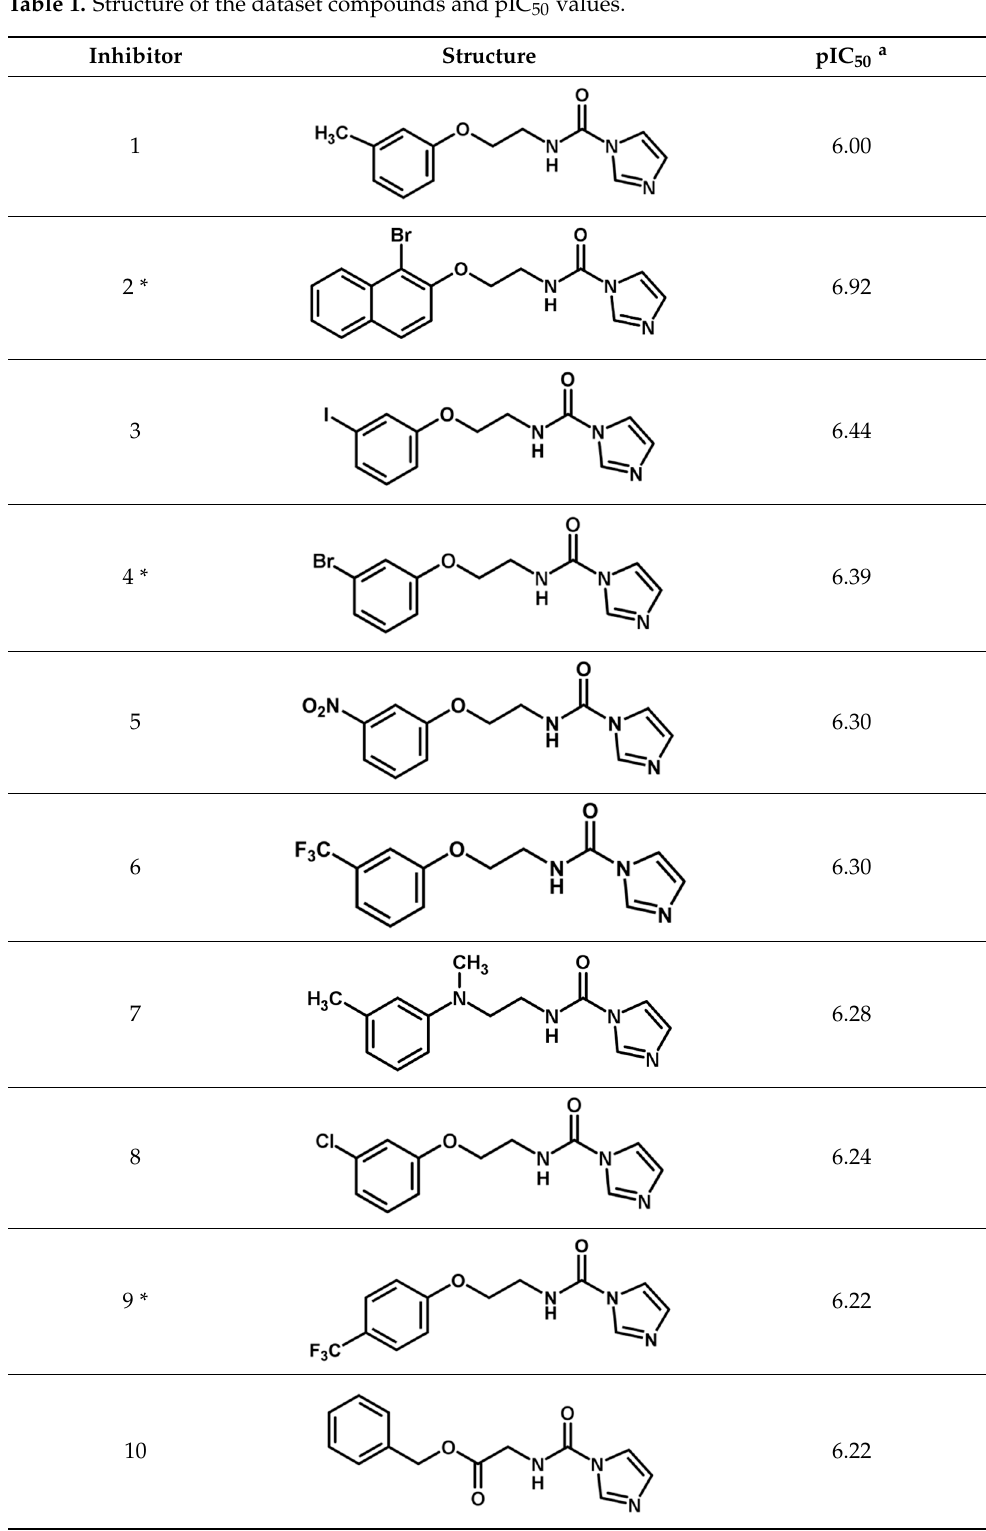
Table 1. Structure of the dataset compounds and pIC 50 values.